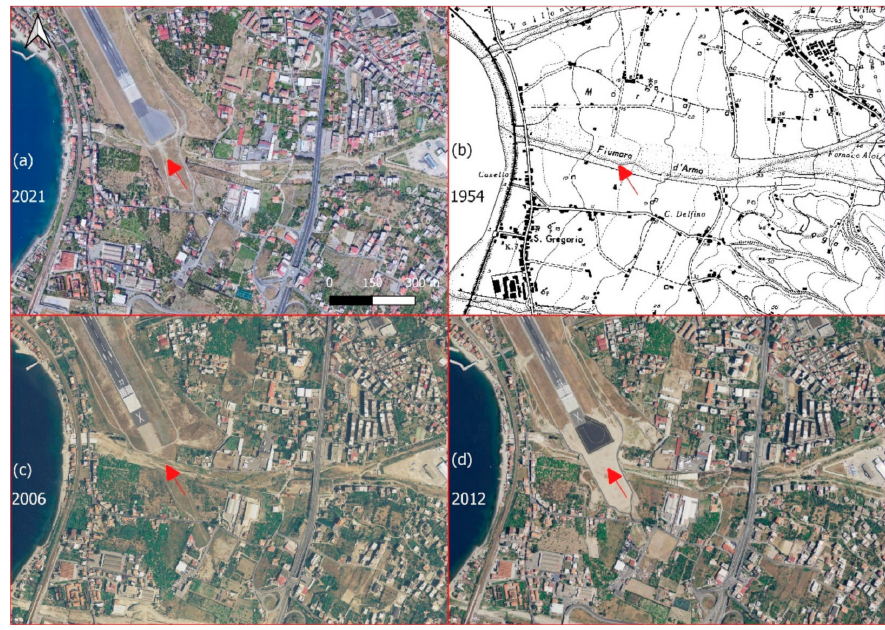
Figure 5. The Armo River. ( a ) An image from Google Earth from September 2021. ( b ) The CASMEZ cartography from 1954. ( c ) The orthophoto from 2006. ( d ) The orthophoto from 2012. The arrows identify the point where the southern end of the airport runway has been